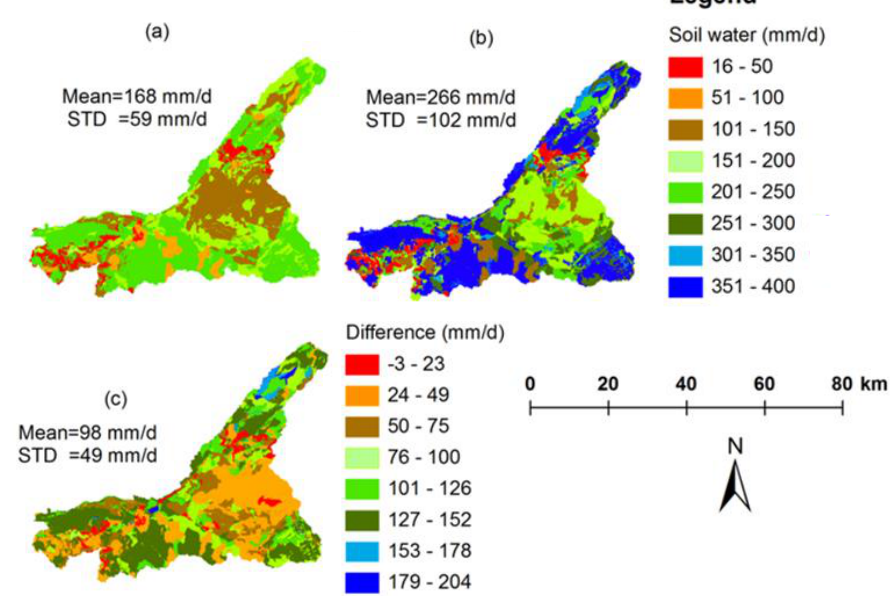
Figure 16. Spatial distribution of the SWAT simulated soil water content at the HRU level for 5 May 2002: ( a ) calibrated using streamflow signatures (FDC); ( b ) calibrated using streamflow signa- tures and ET-RS (FDC+ET); and ( c ) the difference between the two (b – a).